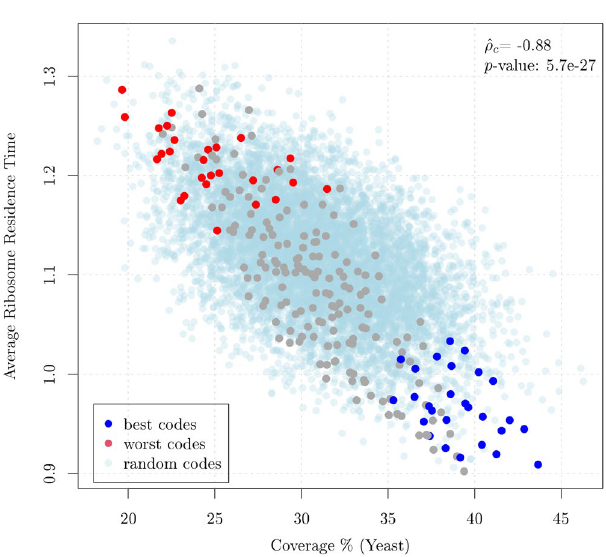
Figure 5. Average Ribosome Residence Time (RRT) versus Coverage (percent) computed on the 216 circular codes partitioned in 27 equivalence classes of 8 codes each. The points in blue and red correspond to the 27 best and 27 worst codes within their associated equivalence class, respectively. Similarly to the experiments shown above, the coverage is a predictor of the RRT and the best and worst codes within their equivalence class clusterize. The results for 8000 random codes are also shown in light blue and the p -value for the test that the observed correlation is equal to that of random codes is